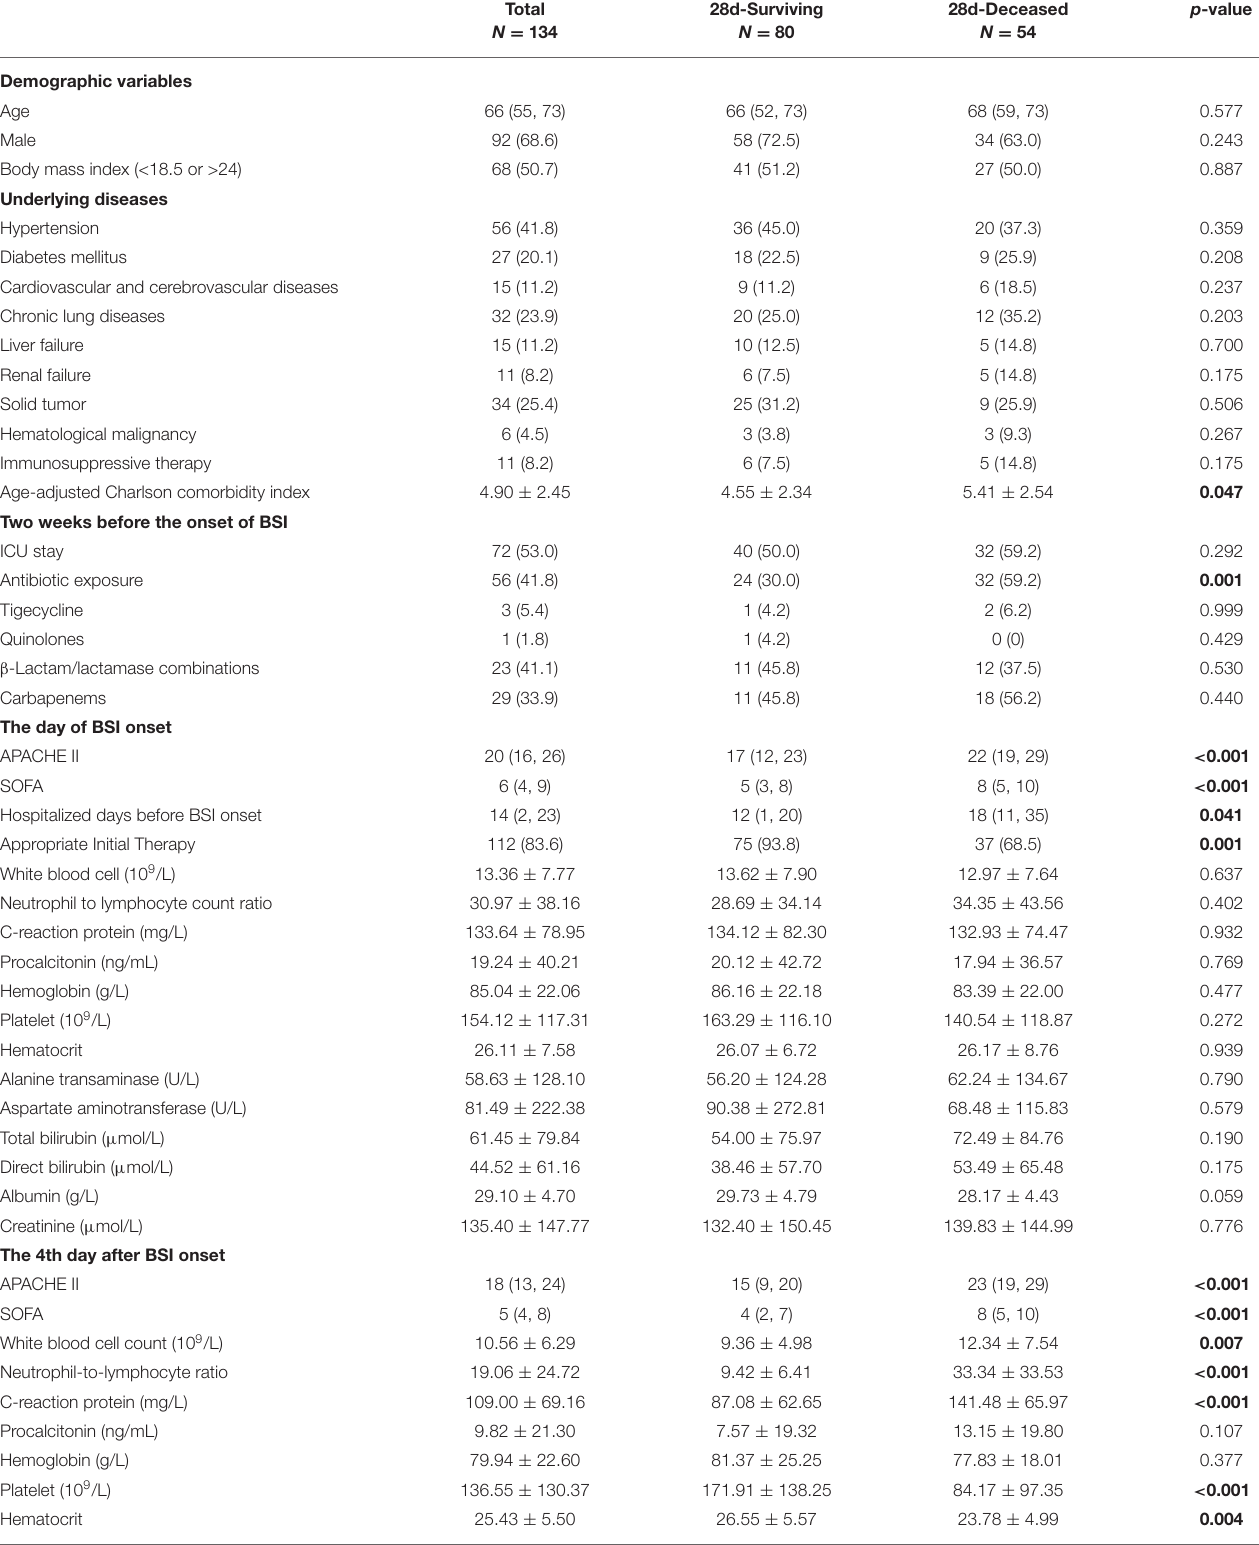
TABLE 1 | Clinical and demographic characteristics of 134 patients with CRKP BSI and risk factors for 28-day